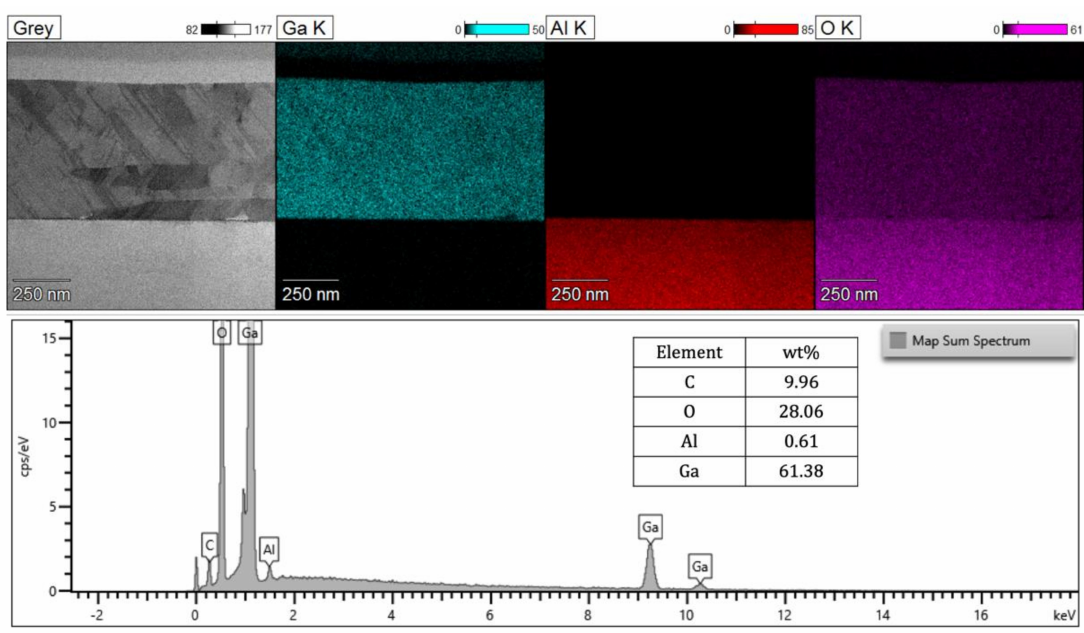
Figure 3. Energy-dispersive X-ray spectroscopy (EDS) analysis performed from the as-grown superlattice structure based on In 2 O 3 grown with 70 sccm of TMIn (Structure 3) through both TEM and